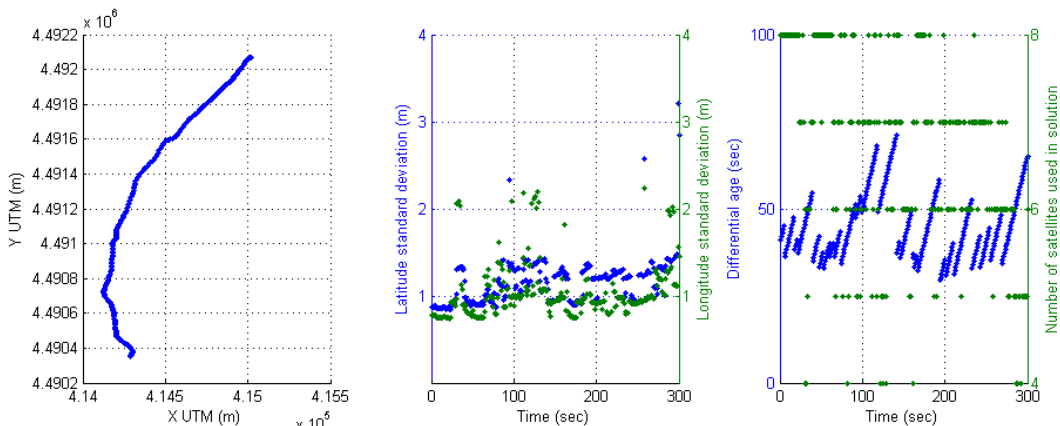
Figure 4. Soft urban environment where differential correction is active: ( a ) Left graph, DGPS trajectory. ( b ) Middle graph, DGPS accuracy. ( c ) Right graph, differential age and number of satellites used in